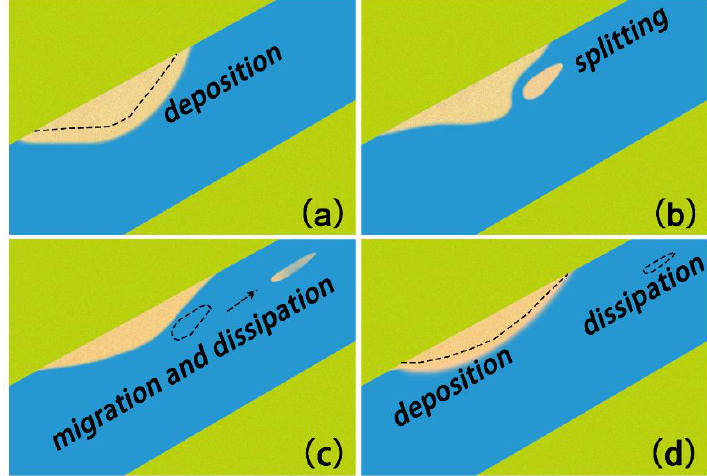
Figure 1. Diagrammatic sketch of the periodic evolution process of the Jingjiang Sandbank (JJS) including increase, split, migration, and dissipation. ( a ) increase process of the sandbank; ( b ) split process of the sandbank; ( c ) generally migration and dissipation of the split detached bar; ( d ) totally dissipation of the split detached bar and deposition again of the sandbank.